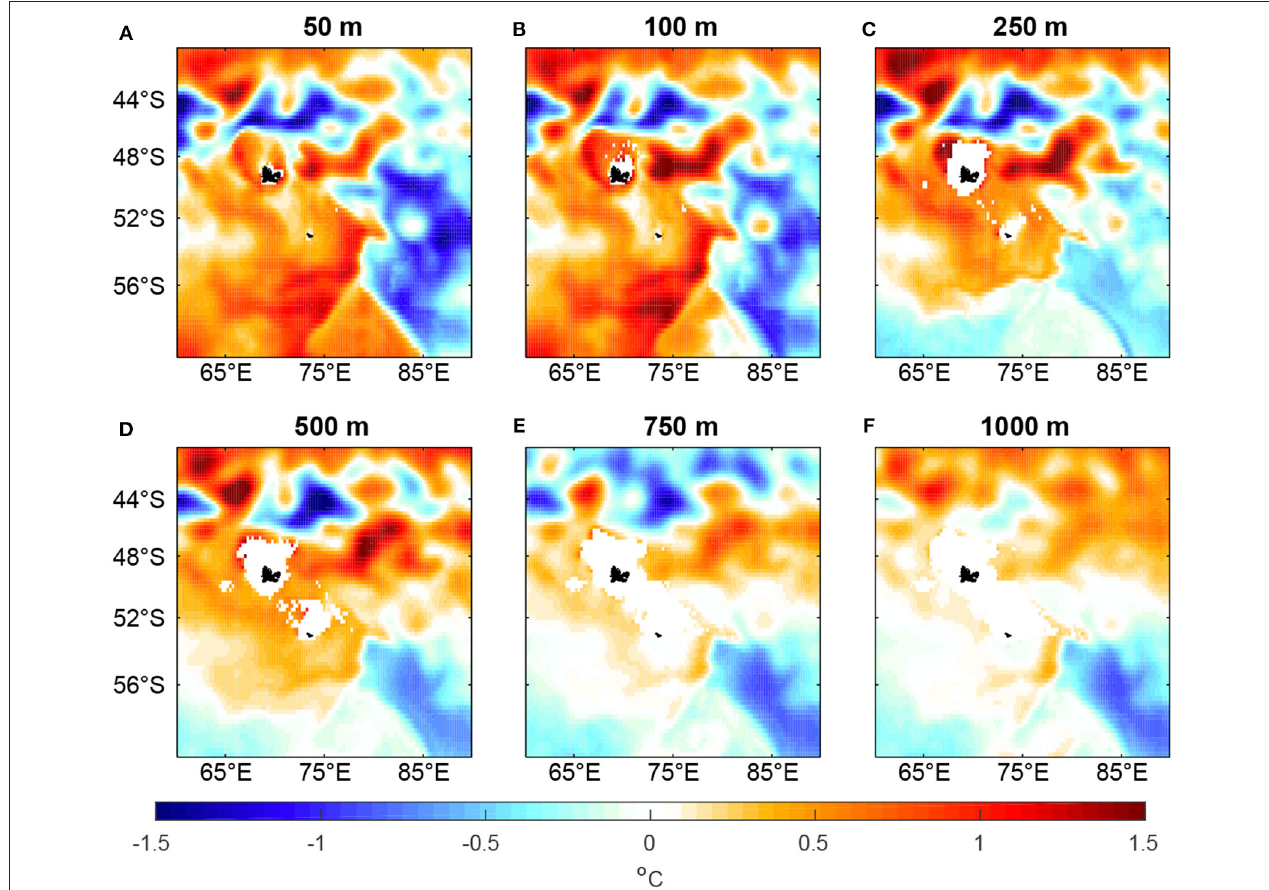
FIGURE 2 | Temperature difference between OFAM and WOA2013 at (A) 50 m, (B) 100 m, (C) 250 m, (D) 500 m, (E) 750 m, and (F) 1,000m.